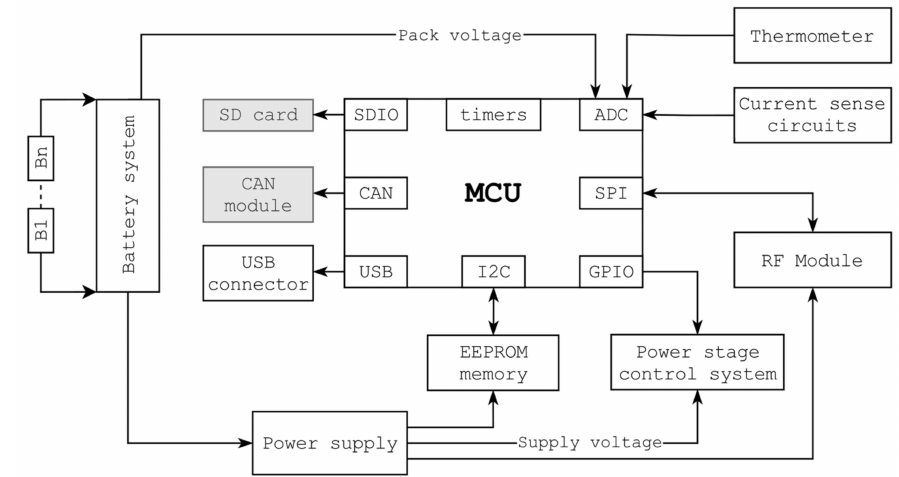
Figure 4. Generic diagram of the BMS Master Controller.